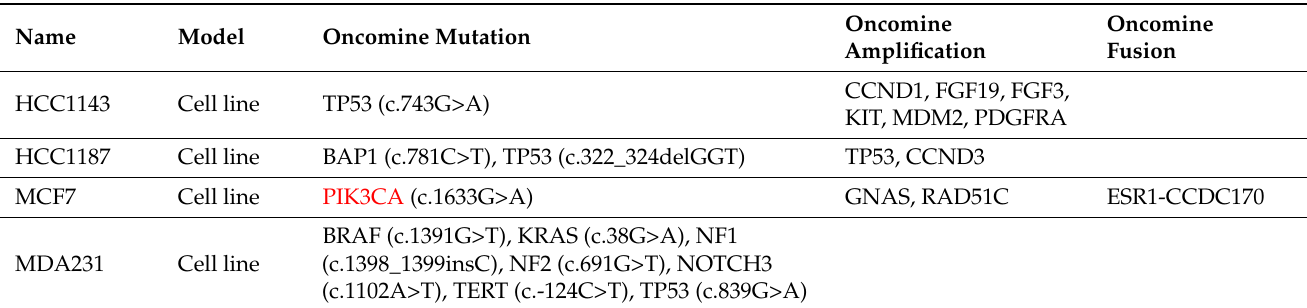
Table 1. Oncomine V3 revealed clinically actionable pathogenic calls. The 34 BRCR models probed with Oncomine sequencing of 229 targeted oncogenic aberrations, returning the status of known mutations, DNA CNVs, and RNA fusion drivers. Models with genes with * were sequenced twice, those marked appeared both times. Pathogenic aberrations in PIK3CA are highlighted in red and in PTEN are highlighted in orange. “CR” denotes treatment with